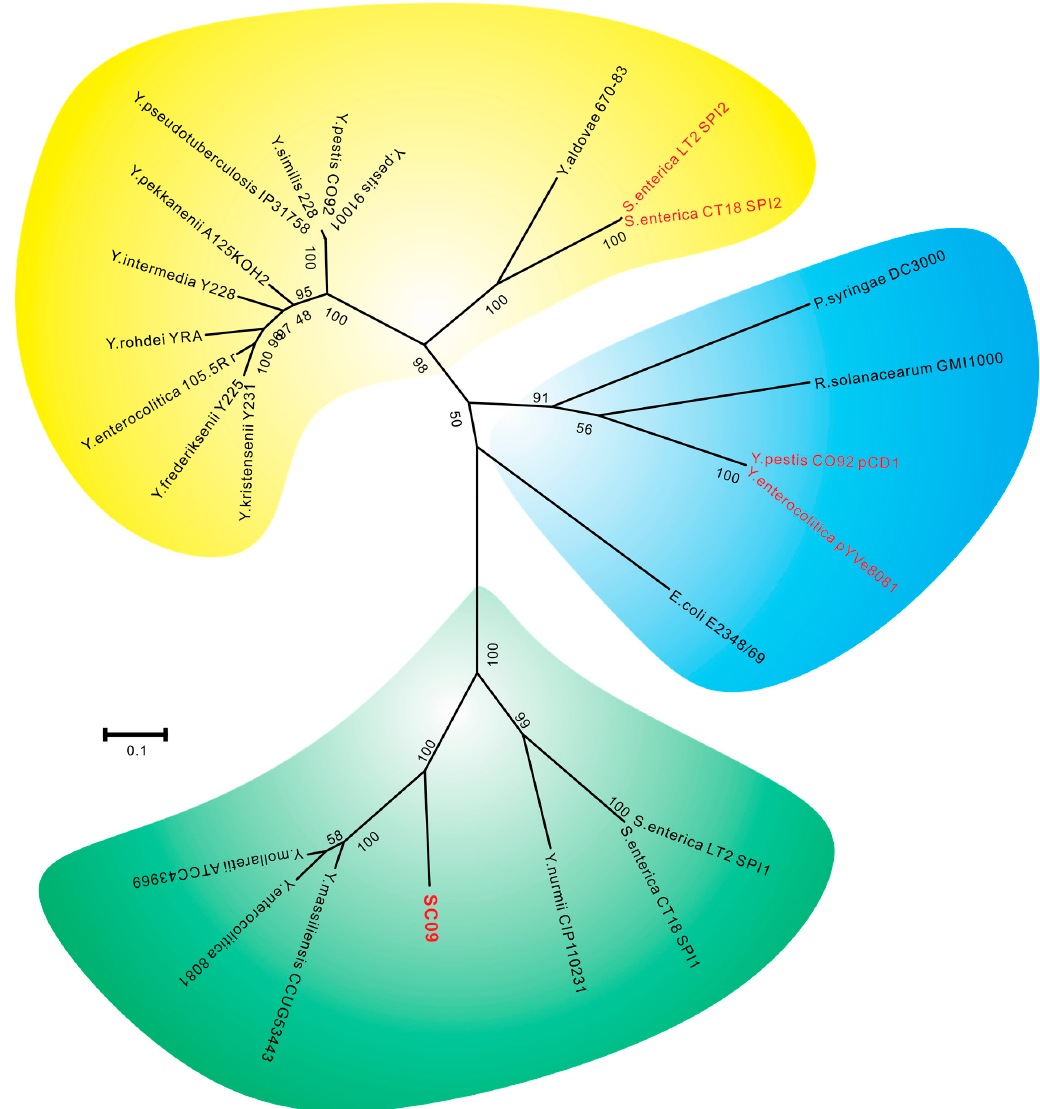
Figure 7. Maximum likelihood phylogenetic tree of the T3SS based on the ATPase amino acid sequences. Values shown on tree branches indicate the percentage of trees among 100 bootstrap replicates carrying that particular branching.